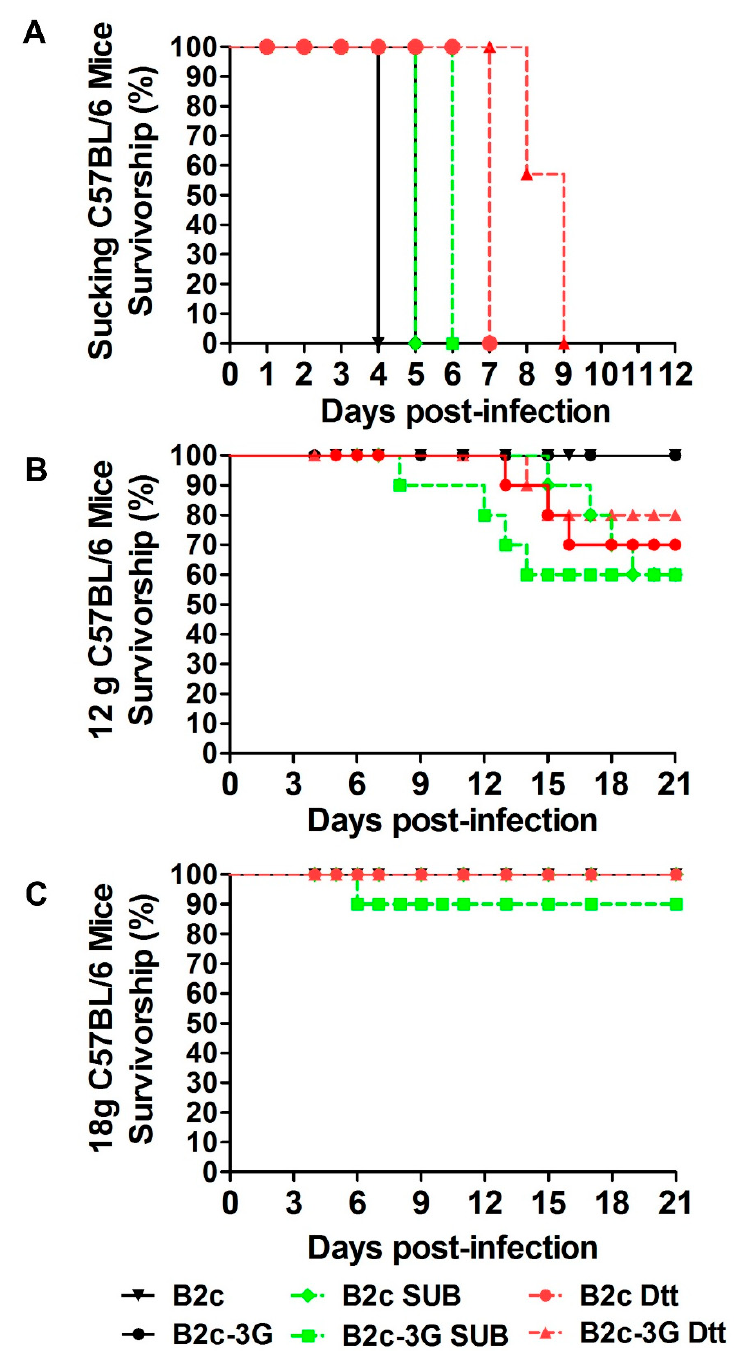
Figure 6. Removal of G from RABV virions increased viral pathogenicity. ( A ) Survivorship of suckling mice infected with the indicated viruses or through i.c. inoculation. The statistical significance of differences in survival rates were analyzed by Kaplan–Meier plots ( n = 10 in each group, log rank p < 0.05). ( B ) Survivorship of 12 g mice infected with the indicated viruses through IM inoculation. ( C ) Survivorship of 18 g mice infected with the indicated viruses through IM inoculation.